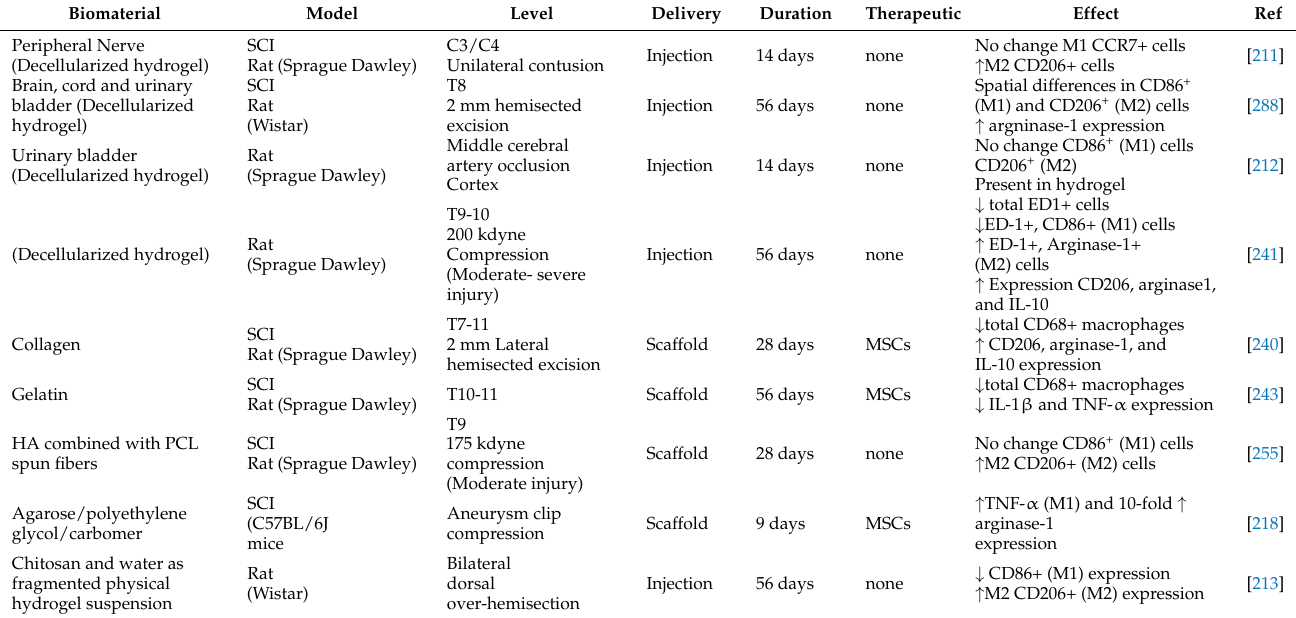
Table 4. Organic and synthetic constructs used to induce macrophage polarization in central nerve injury. Where ↑ indicates an increase in specific cells population and ↓ indicates a decrease in specific cell